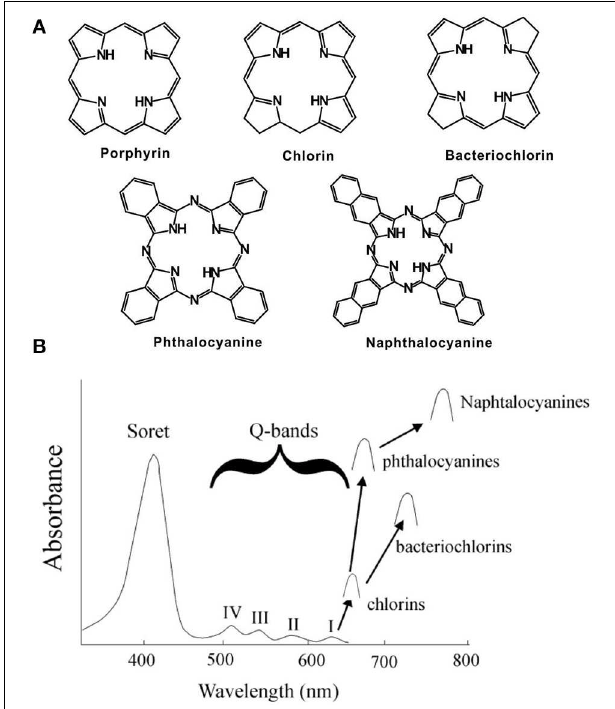
FIGURE 1 | (A) Structure and (B) Absorption of typical porphyrins, chlorins, bacteriochlorins, phthalocyanine and naphthalocyanines. Arrows show Q-band absorption (Adapted with permission from Berg et al. [